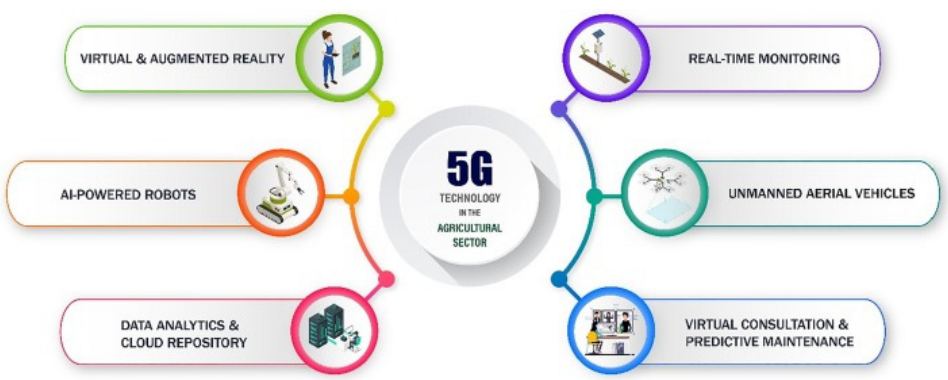
Figure 1. The evolutionary phases of agriculture [2].